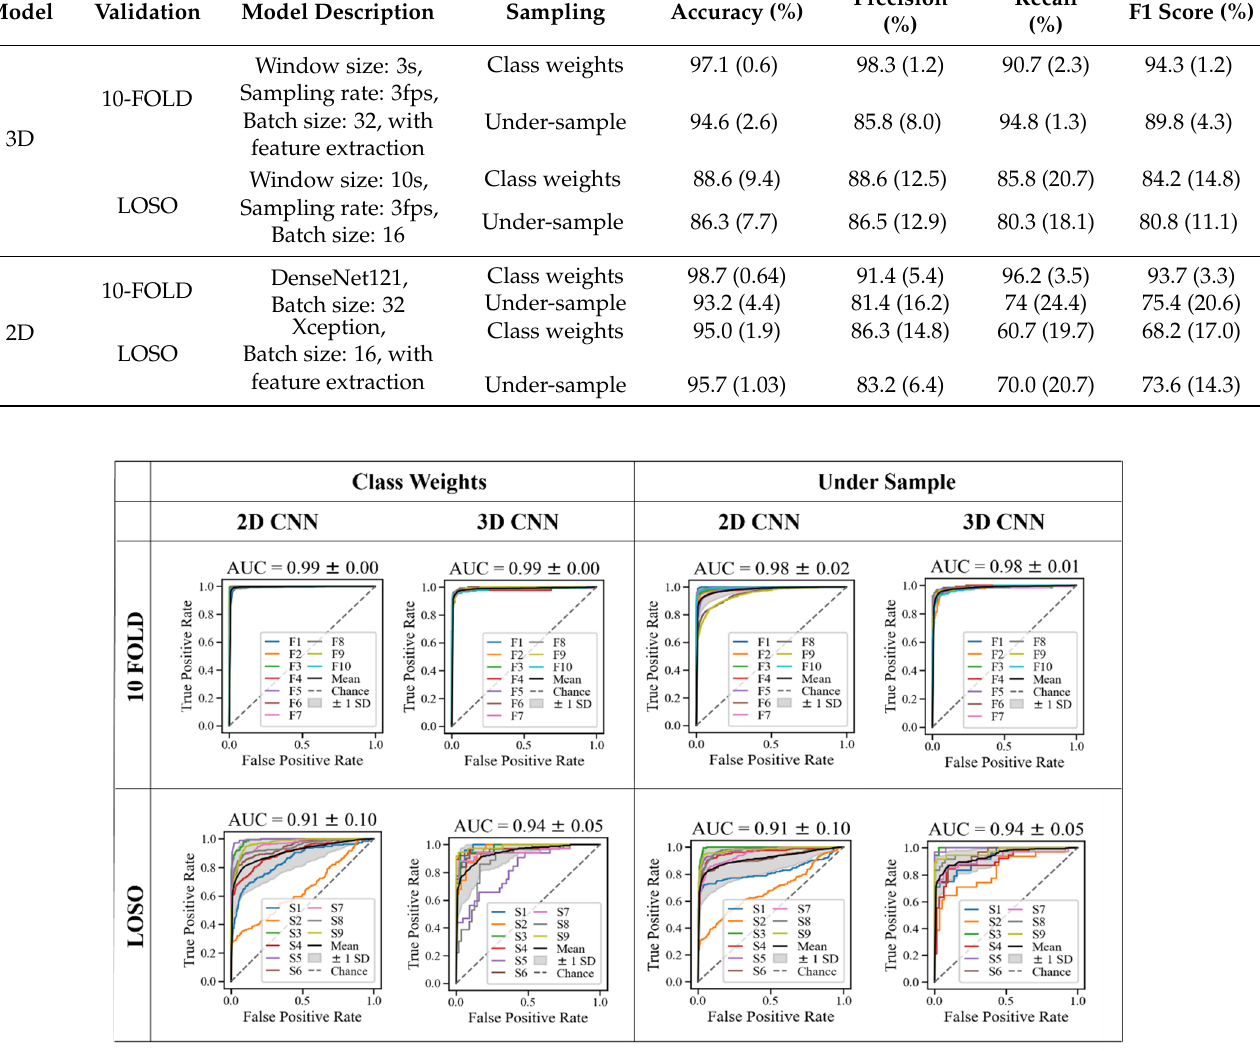
Figure 6. Receiver operating characteristic (ROC) curve for the top models. F x refers to the fold number x and S x refers to the subject number x who has held out in the LOSO validation.